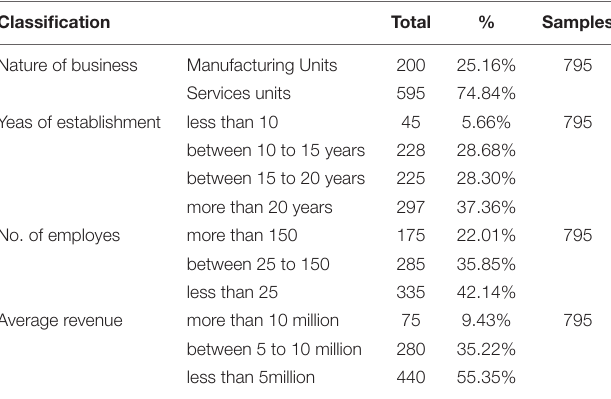
TABLE 3 | Demographic profiles of research